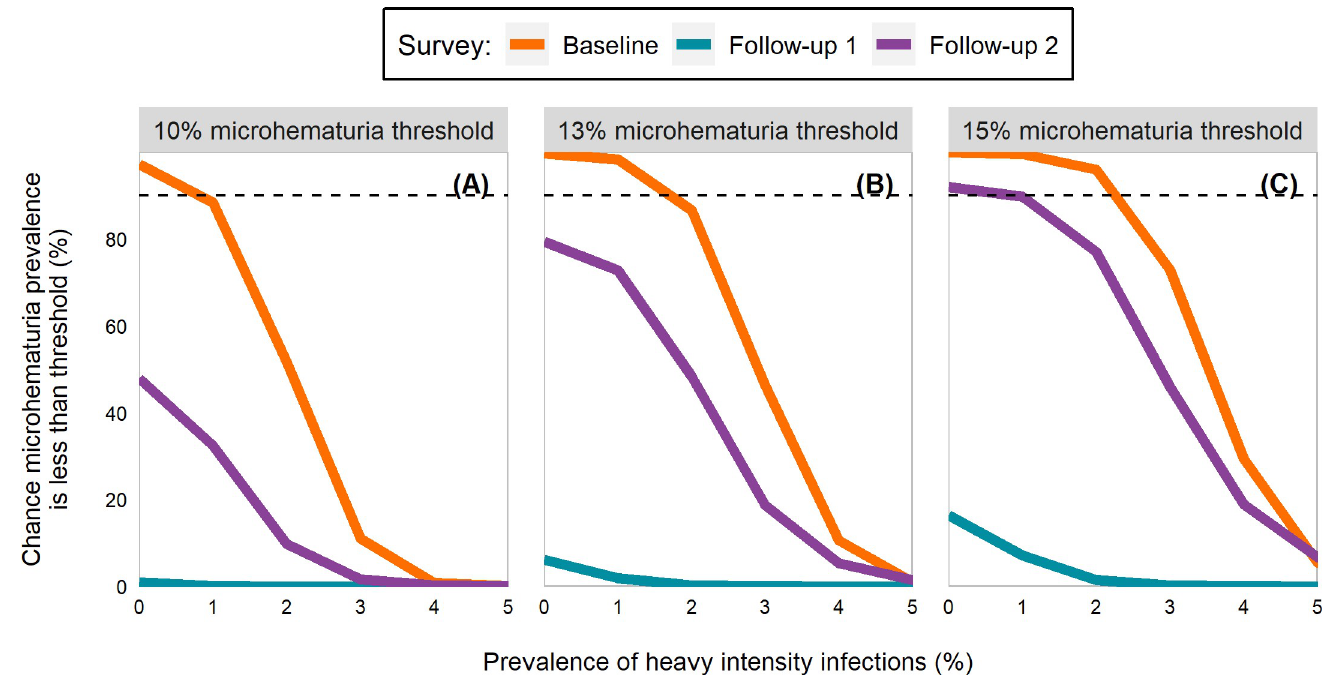
Fig 4. Line plots by survey of the percent chance a school with a given Schistosoma haematobium prevalence of heavy intensity infections is below the microhematuria threshold. Panel A is for a 10% microhematuria threshold, panel B for 13%, and panel C for 15%. Estimates utilized children aged 6–15 years from Burkina Faso, Mali, Niger, Tanzania, and Zambia participating in schistosomiasis control program activities between 2003 and 2008. Full description of the methods is in S1 Text. The dashed line indicates a 90% chance of being below the threshold.